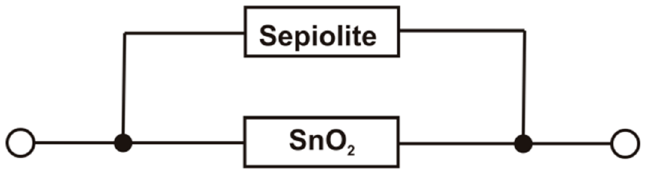
Figure 9. An equivalent electric circuit of the structure of the resistive gas sensor with a passive sepiolite filter.